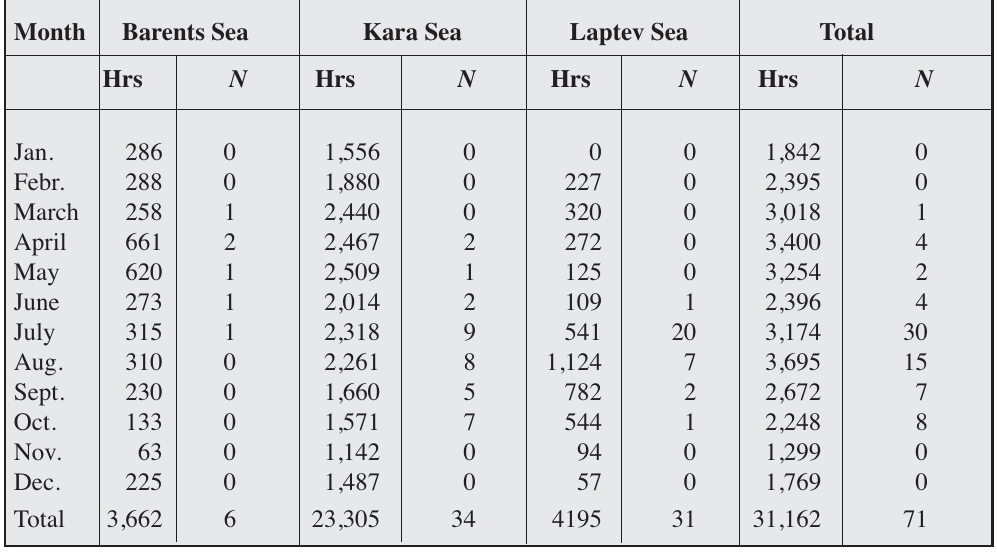
Table 2. Duration of ARSI flights and summarised monthly numbers of beluga observations ( N ) in the Barents, Kara and Laptev seas,